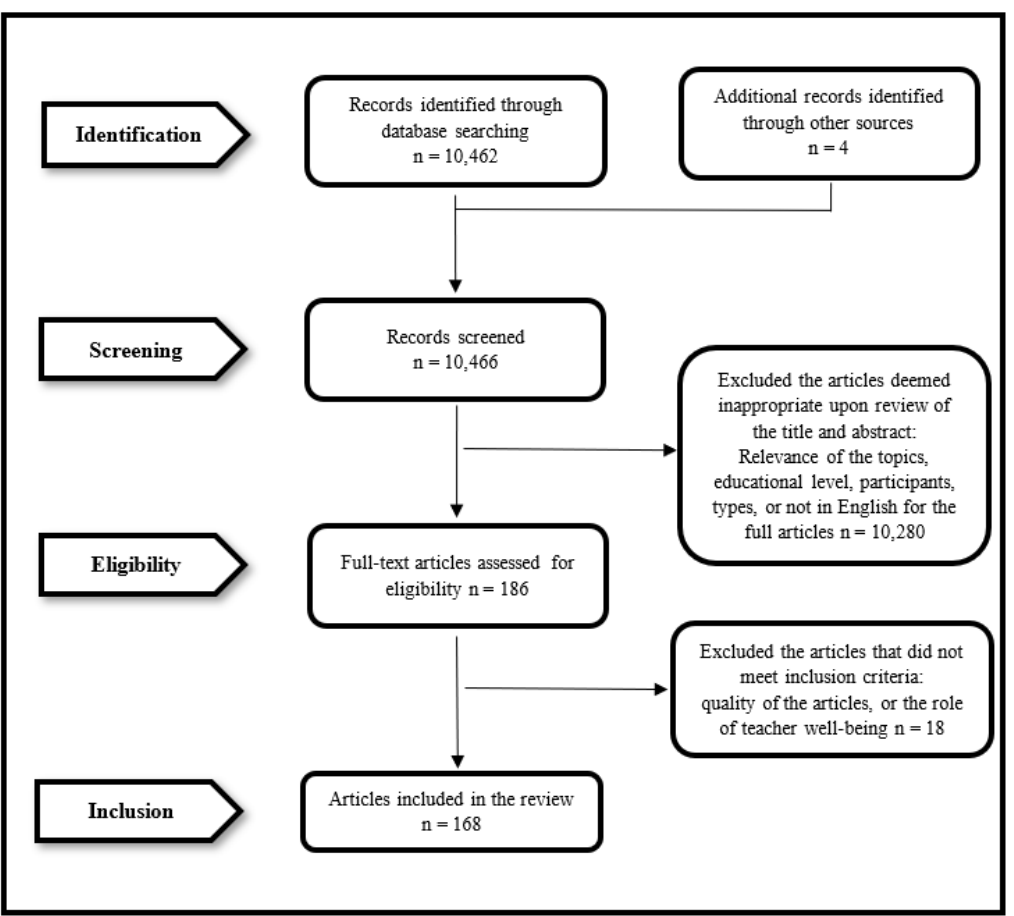
Figure 1. Flow Chart of Search and Screening Process.